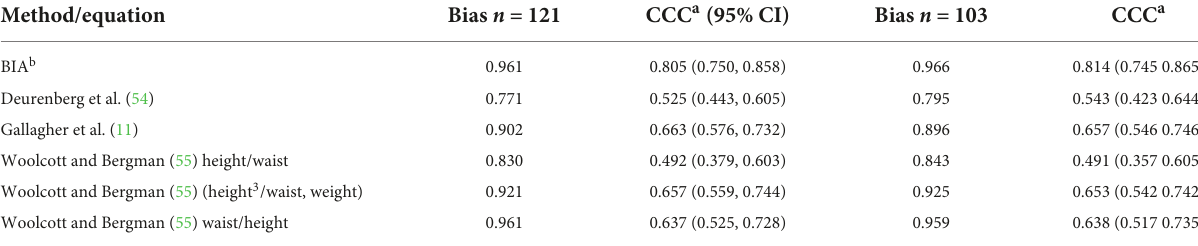
TABLE 4 Bias and concordance correlation coefficient for percentage body fat using BIA and equations based on anthropometric measurements in the entire group (121) and a subgroup.